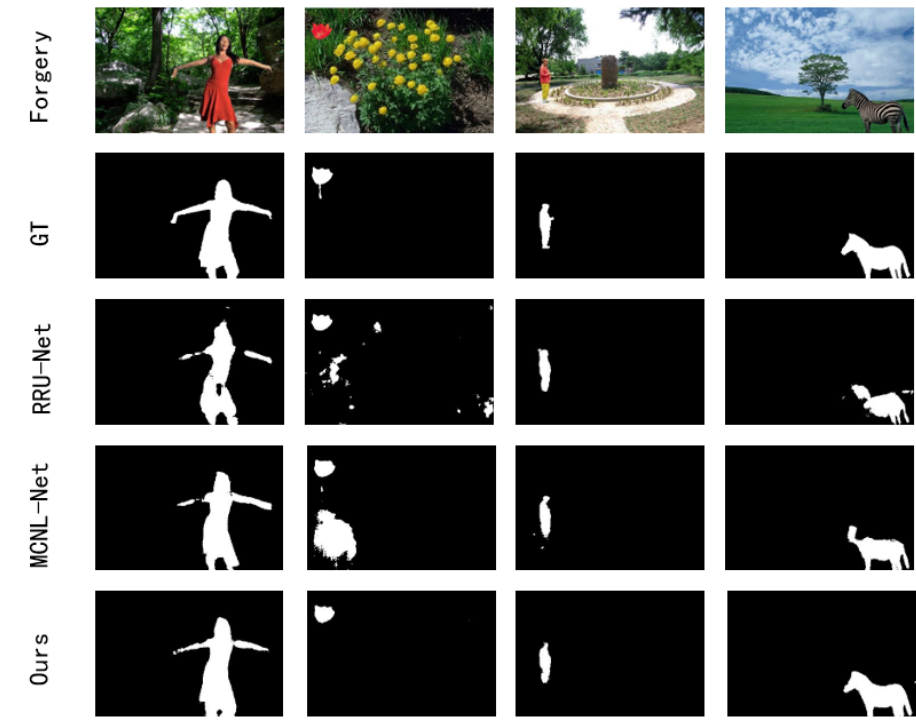
Figure 8. Visualization of the forgery detection results predicted by various methods. From top to bottom, we show the forgery image, the GT mask and predicted results of RRU-Net, MCNL-Net and